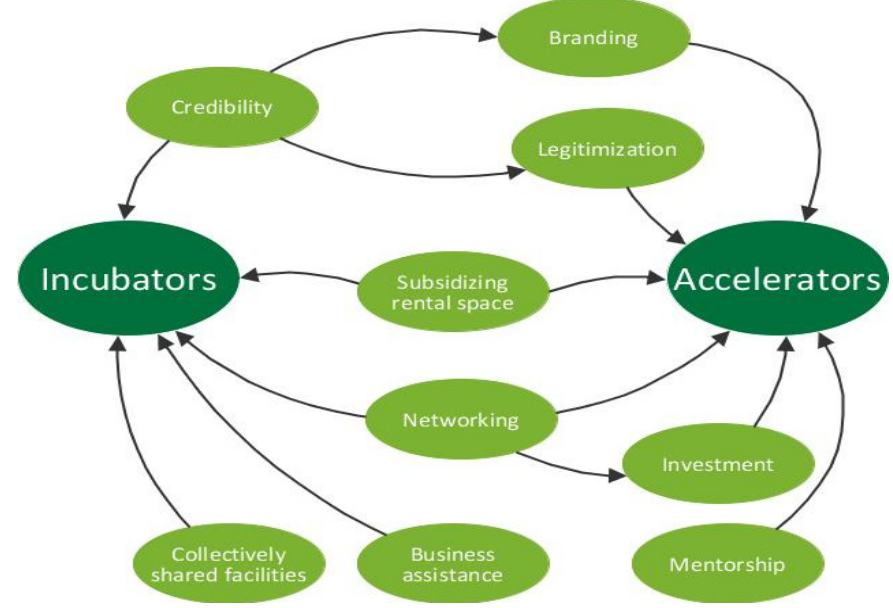
Figure 1. Key features of BAIs as per Schwartz [21] and Wise and Valliere [24].